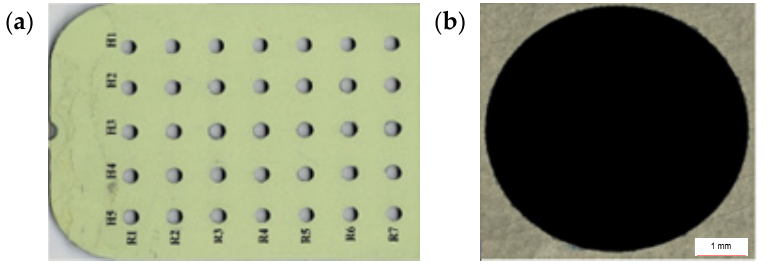
Figure 2. Observation of ( a ) exit ( b ) close-up view of delamination at the exit using an Alicona InfinateFocus optical